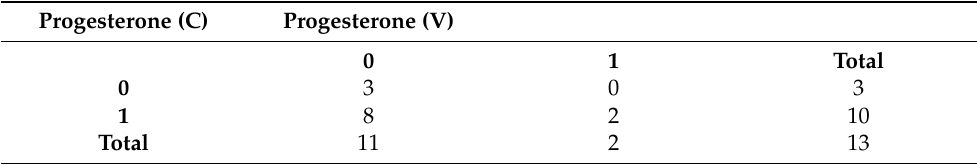
Figure 1. ( a ) Age of the calves in group V and their progesterone values over time. The red line represents the progesterone value of 1 ng/mL in serum. Only three calves exceeded a progesterone value of 1 ng/mL. ( b ) Age of the calves in group C and their progesterone values over time. The red line represents the progesterone value of 1 ng/mL in blood. The youngest heifer exceeding the progesterone value of 1 ng/mL was 286 d old. This animal had a progesterone value of 8.7 ng/mL at the second injection. The corresponding cortisol value was 57.1 nmol/L and close to our threshold of 60 nmol/L. Table 2. The McNemar test for the frequency table whether a vaccinated calf and a control calve within a farm had a progesterone value above 1 ng/mL during the whole measuring period revealed a significant difference ( p =